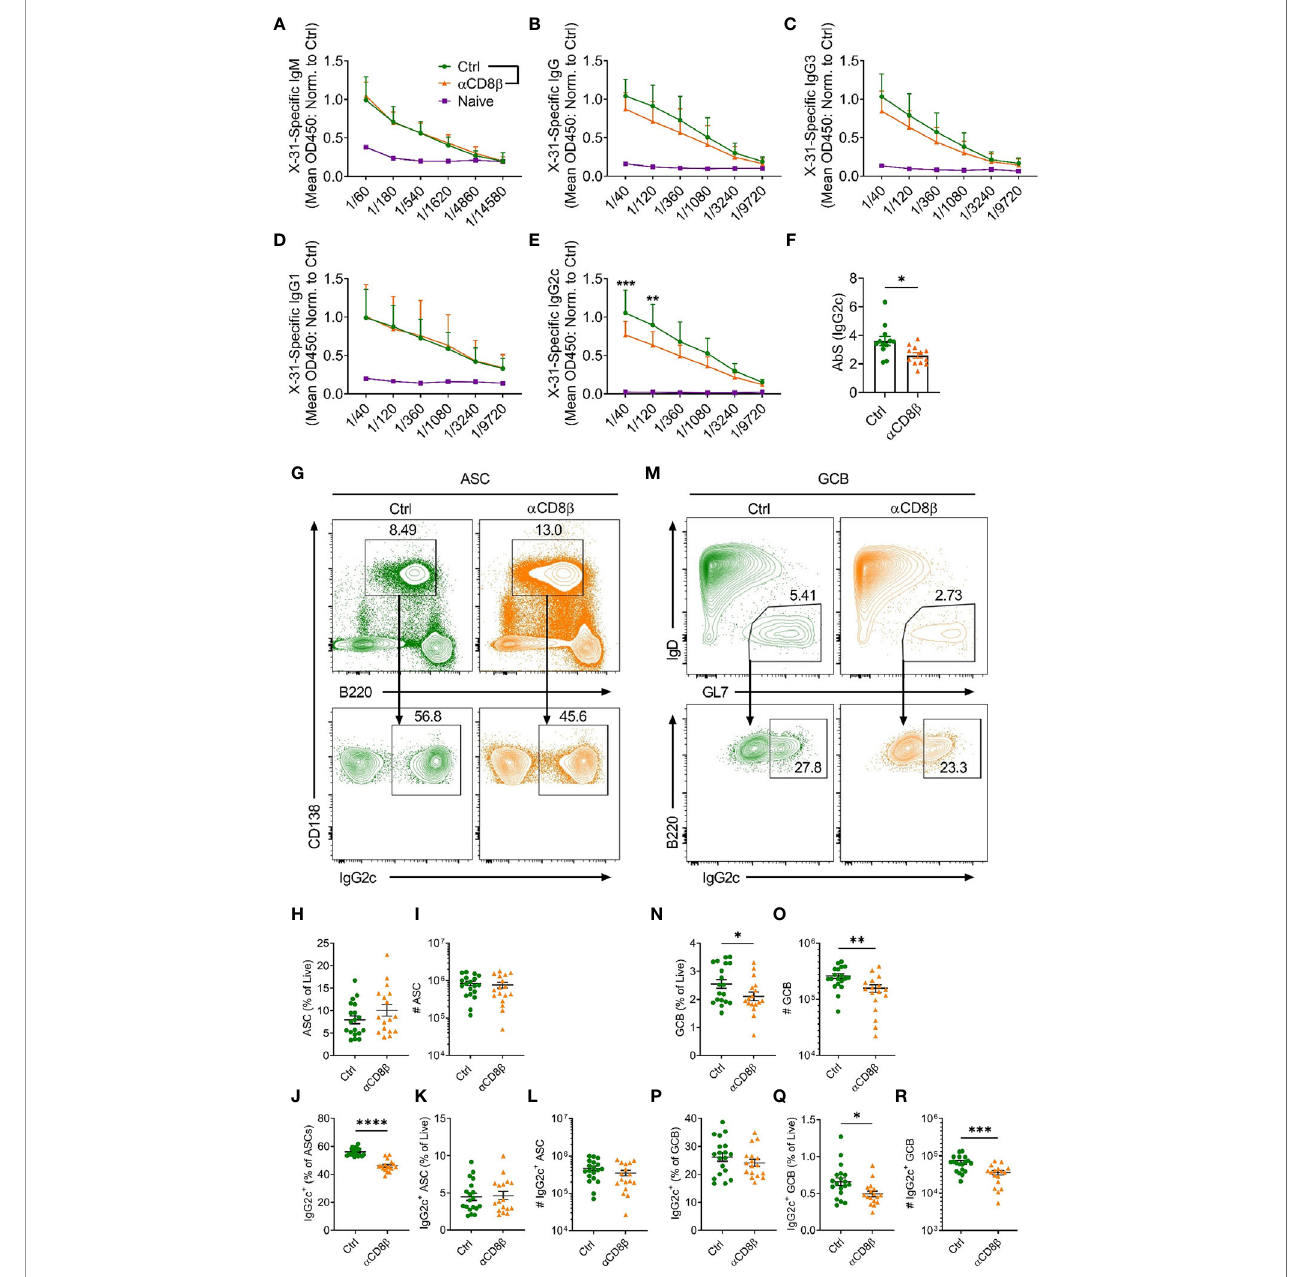
FIGURE 4 | CD8 + T cells support induction of IgG2c responses against IAV. C57BL/6 mice were treated i.p. with either a CD8 b or control antibody 4 days before and on day 4 after i.n infection with x31 and harvested on day 8 post-infection. Levels of serum x31-speci fi c (A) IgM, (B) IgG, (C) IgG3, (D) IgG1 and (E) IgG2c assessed by ELISA. (F) Absorption summation (AbS) analysis of the x31-speci fi c IgG2c ELISA data in (E) . AbS is determined by adding the absorbance values from all dilutions to obtain a single value for each biological replicate (25). (G) Gating strategy used for identi fi cation of CD138 + B220 int ASCs and IgG2c-switching in ASCs in the mLN. Cells in the top panel were pre-gated on live, single cells. (H, I) Quanti fi cation of the ASC response by (H) frequency and (I) number. (J – L) Analysis of the IgG2c + ASC response by (J) proportion of total ASCs, (K) frequency of total live cells and (L) number. (M) Gating strategy used for identi fi cation of B220 + IgD - GL7 + GCB cells and IgG2c-switching in GCB cells in the mLN. Cells in the top panel were pre-gated on live, B220 + CD138 - cells. (N, O) Quanti fi cation of the GCB cell response by (N) frequency and (O) number. (P – R) Analysis of the IgG2c + GCB cell response by (P) proportion of total GCB cells, (Q) frequency of total live cells and (R) number. (A – F) Data are pooled from two independent experiments with a total of 12 mice per group (Ctrl and a CD8 b ) or 3 mice (Naïve) and the absorbance values for the ELISA data have been normalised to the average of the Ctrl group for each independent experiment prior to pooling the data. (H – L, N – R) Data